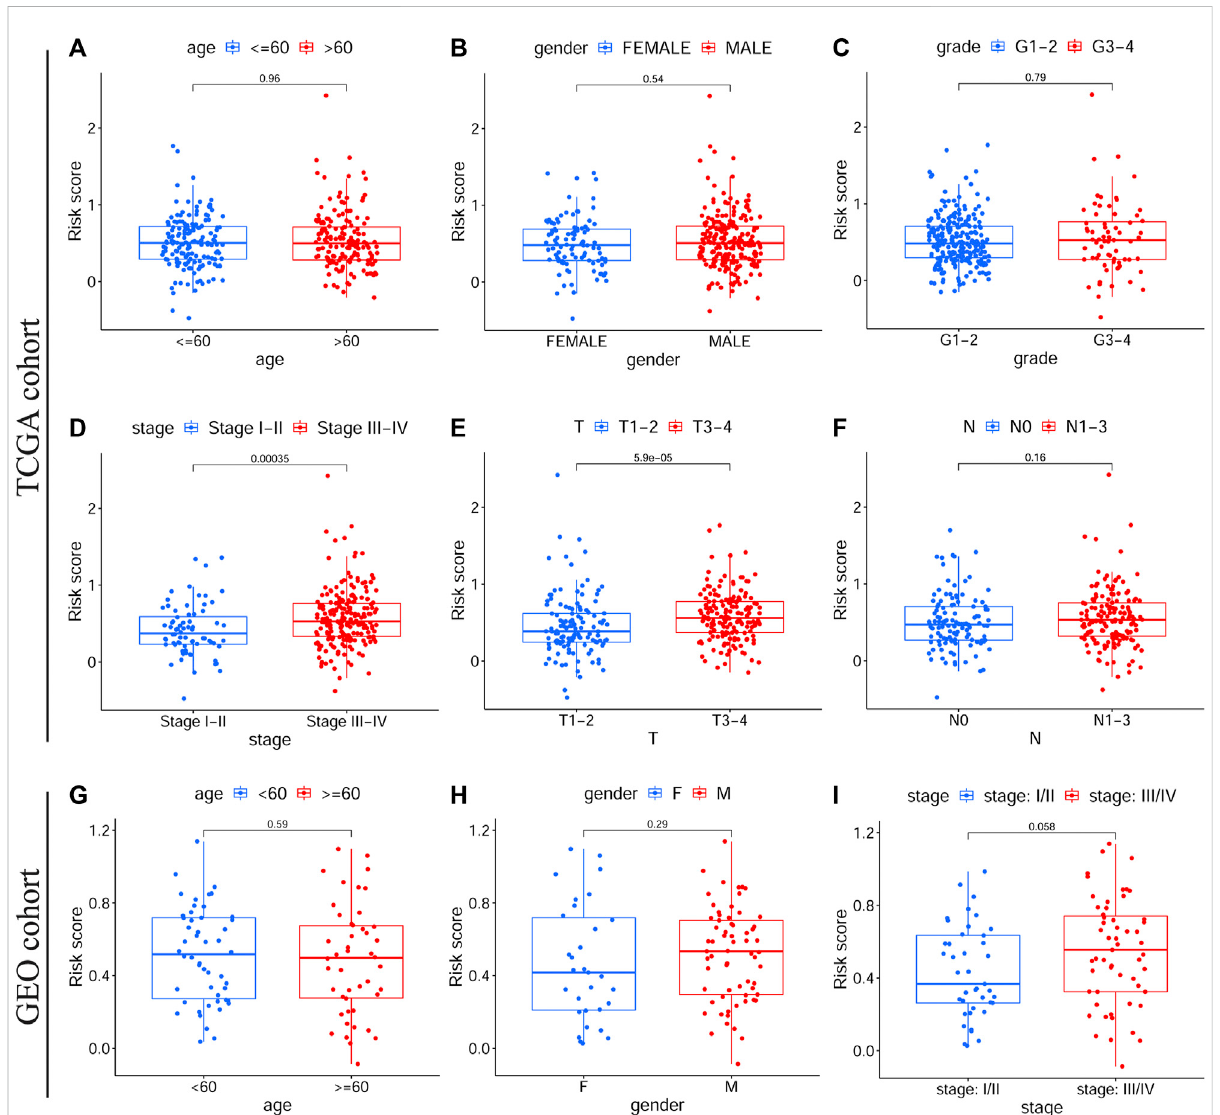
FIGURE 3 Thecorrelationsbetweenclinicalfeaturesandtheprognosticsignature.DifferentriskscoresinOSCCpatientswithdifferentage (A) ,gender (B) , grade (C) ,clinicalstage (D) ,Tstage (E) andNstage (F) accordingtoTCGAcohort.DifferentriskscoresinOSCCpatientswithdifferentage (G) ,gender (H) , and clinical stage (I) on basis of the validation cohort. OSCC, Oral squamous cell carcinoma, TCGA, The Cancer Genome